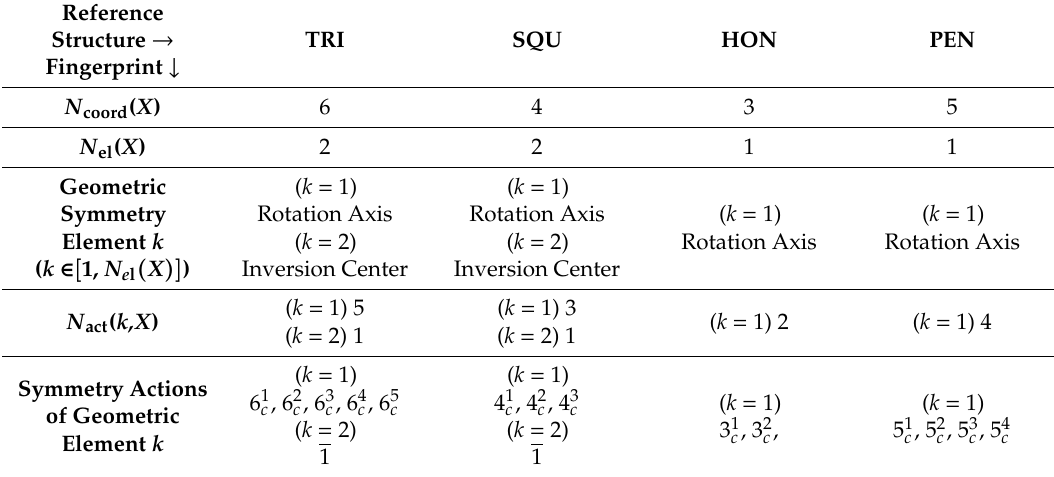
Table 2. Number of nearest neighbors, N coord ( X ), number of distinct geometric symmetry elements N el ( X ), along with their type, number of actions per element, N act ( k , X ) and their type for the 2-D crystals ( X = TRI, SQU and HON) as well as the pentagonal (PEN) local